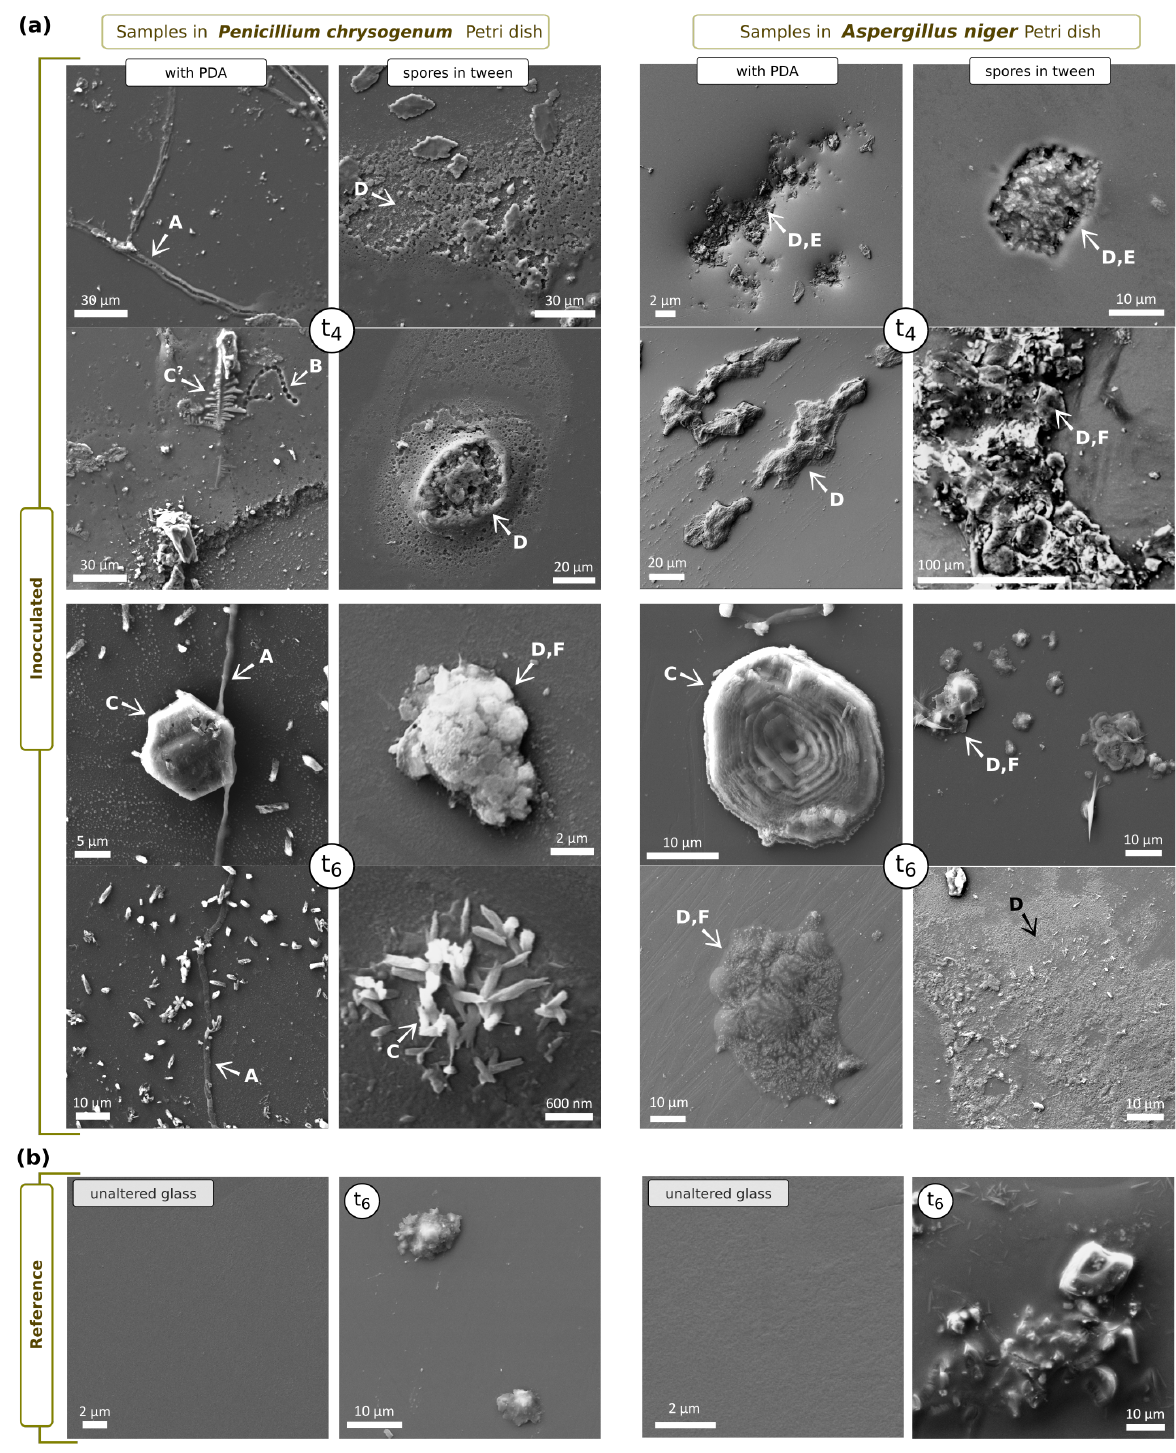
Figure 3. SEM images of samples inoculated with ( a ) Penicillium chrysogenum and Aspergillus niger , in PDA or as spores in Tween solution, at t 4 and t 6 periods of incubation; and ( b ) of the reference samples incubated in the same Petri dishes after 6 months (t 6 ). Legend: (A) hyphae fingerprints; (B) spores fingerprints; (C) crystal formation; (D) depletion/deposition of elements; (E) biopitting; (F)